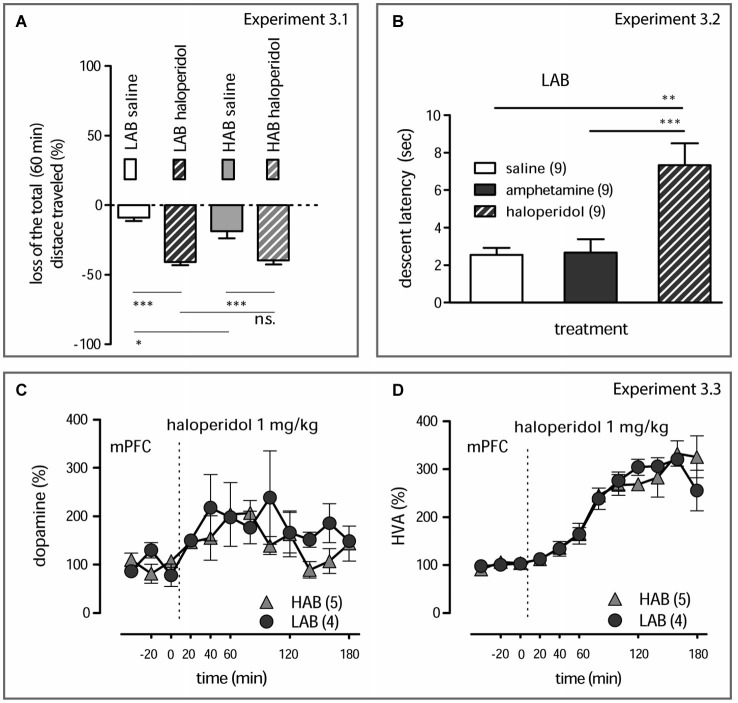
Behavioral and neurochemical effects of haloperidol (A). Haloperidol (1 mg/kg, i.p.) decreases the total distance traveled by both LAB and HAB mice; the corresponding dynamical data are presented in Yen et al. (2013). Relative gains or losses in the mean distance traveled within 60 min after treatment was obtained in comparison to basal activities (last 5 min of pre-treatment 20 min period). A subtle difference between saline-treated LAB and HAB mice reflecting the already reported difference in the short-term habituation rate in these animals (Yen et al., 2013). However, the locomotion-suppressive effects of haloperidol (1 mg/kg, i.p.) were prominent both in LAB and HAB mice and did not differ between lines.***p < 0.001, *p < 0.05, n.s. non significant (Newman-Keuls’s post hoc comparison). (B). Mitigation of locomotor activity by haloperidol (1 mg/kg, i.p.) in LAB mice is mediated by its characteristic neuroleptic activity (development of a cataleptic state) which can be discriminated from the calming action of amphetamine (1 mg/kg, i.p.). **p < 0.01, ***p < 0.001 (Neumann-Keuls’s post hoc comparison). (C,D). Haloperidol (1 mg/kg, i.p.) increases dopamine release in the mPFC and evokes equal accumulation of HVA in both LAB (circles) and HAB (triangles) mice. The dashed line defines the moment of drug administration.